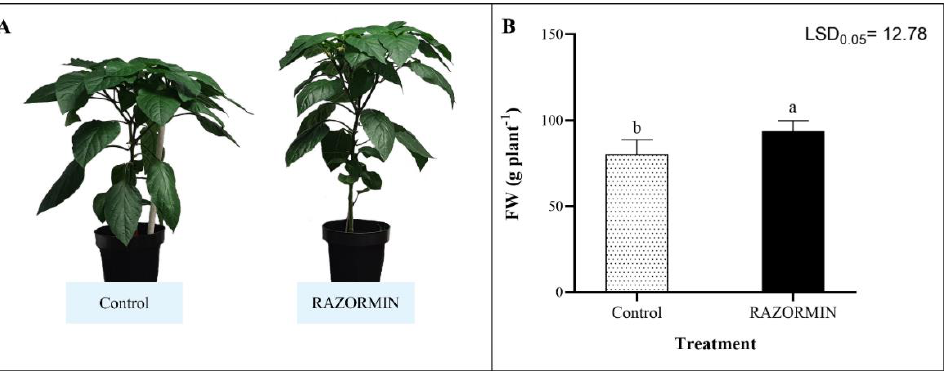
Figure 1. Improved plant growth upon the application of biostimulant RAZORMIN ® . ( A ) Plant with and without biostimulant RAZORMIN ® treatment. ( B ) Fresh weight (FW) of plants with and without biostimulant RAZORMIN ® treatment. All the data values represent means ± SD, ( n = 9). Fisher’s least-significance test (LSD; p = 0.05) was undertaken to analyze the differences between the means. Different letters indicate significantly different values.